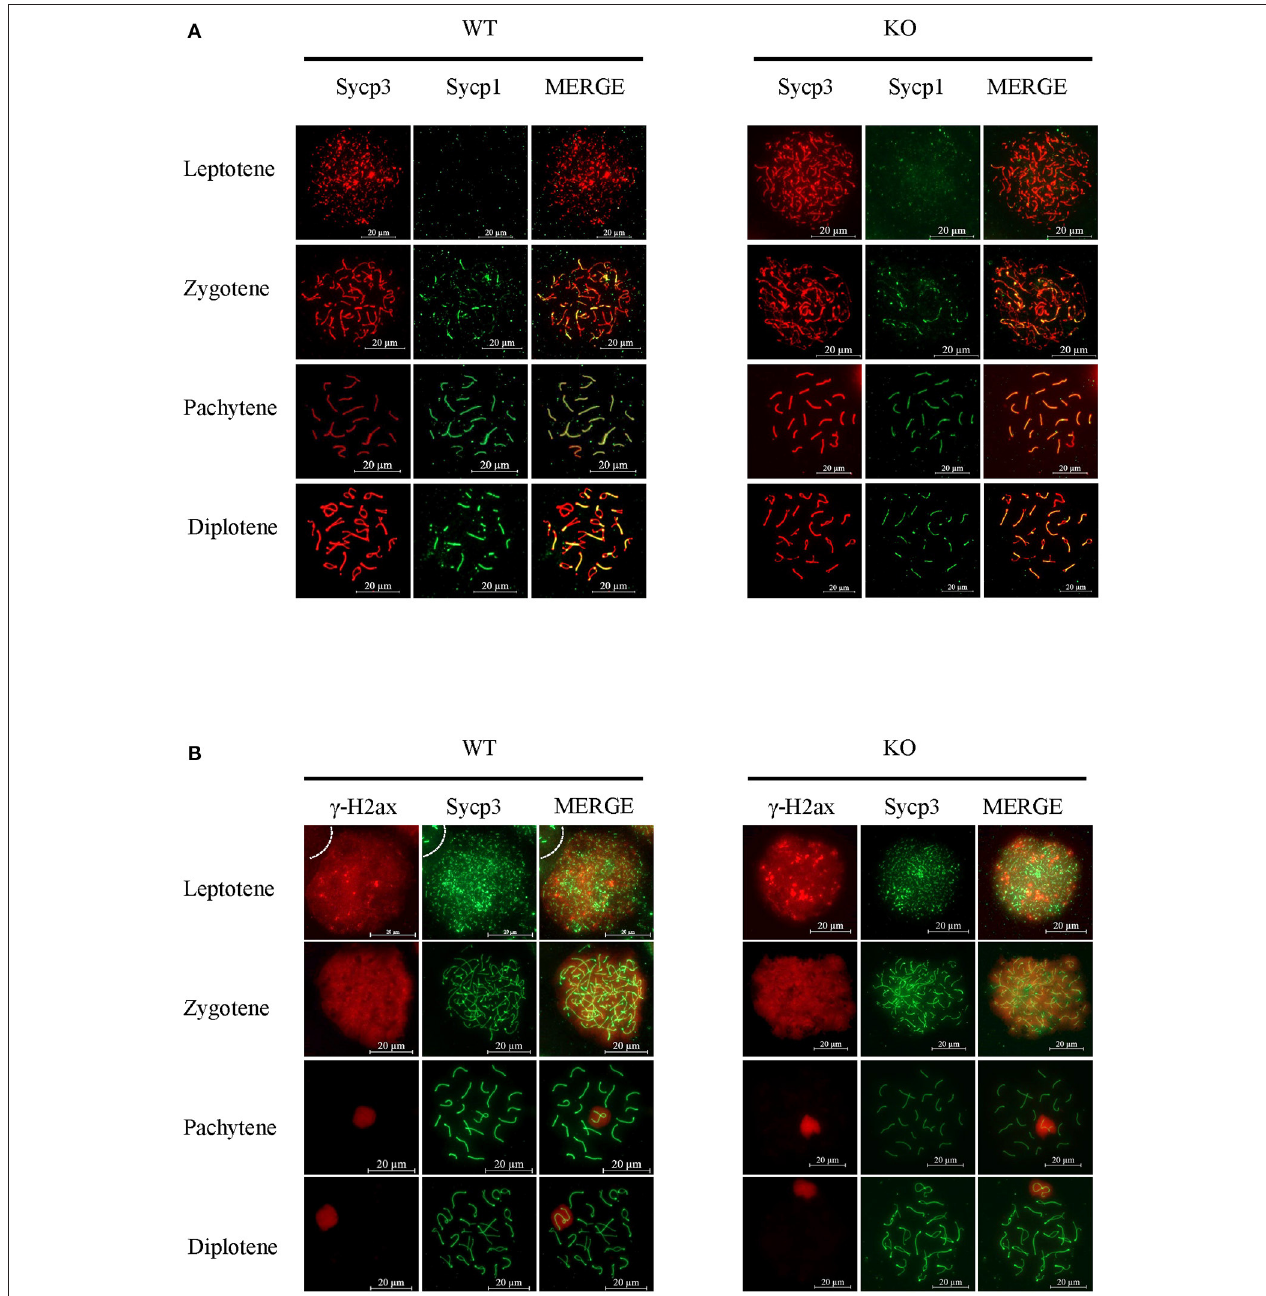
FIGURE 6 | Function of Sugp2 in chromosome synapsis and double-strand break repair in spermatocytes. (A) Chromosome spread from wild-type control and Sugp2 knockout testes was labeled for synaptonemal complex proteins (Sycp1 and Sycp3). (B) Distribution of γ H2ax in wild-type and Sugp2 KO spermatocytes. Scale bar = 20 µ